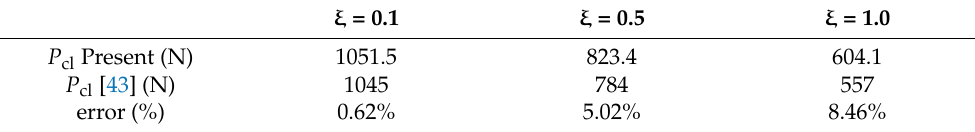
Figure 3. Comparison of present load-displacement results with those of the reference. Table 1. Comparison of the buckling limit loads of the cylinder with different imperfection factors.